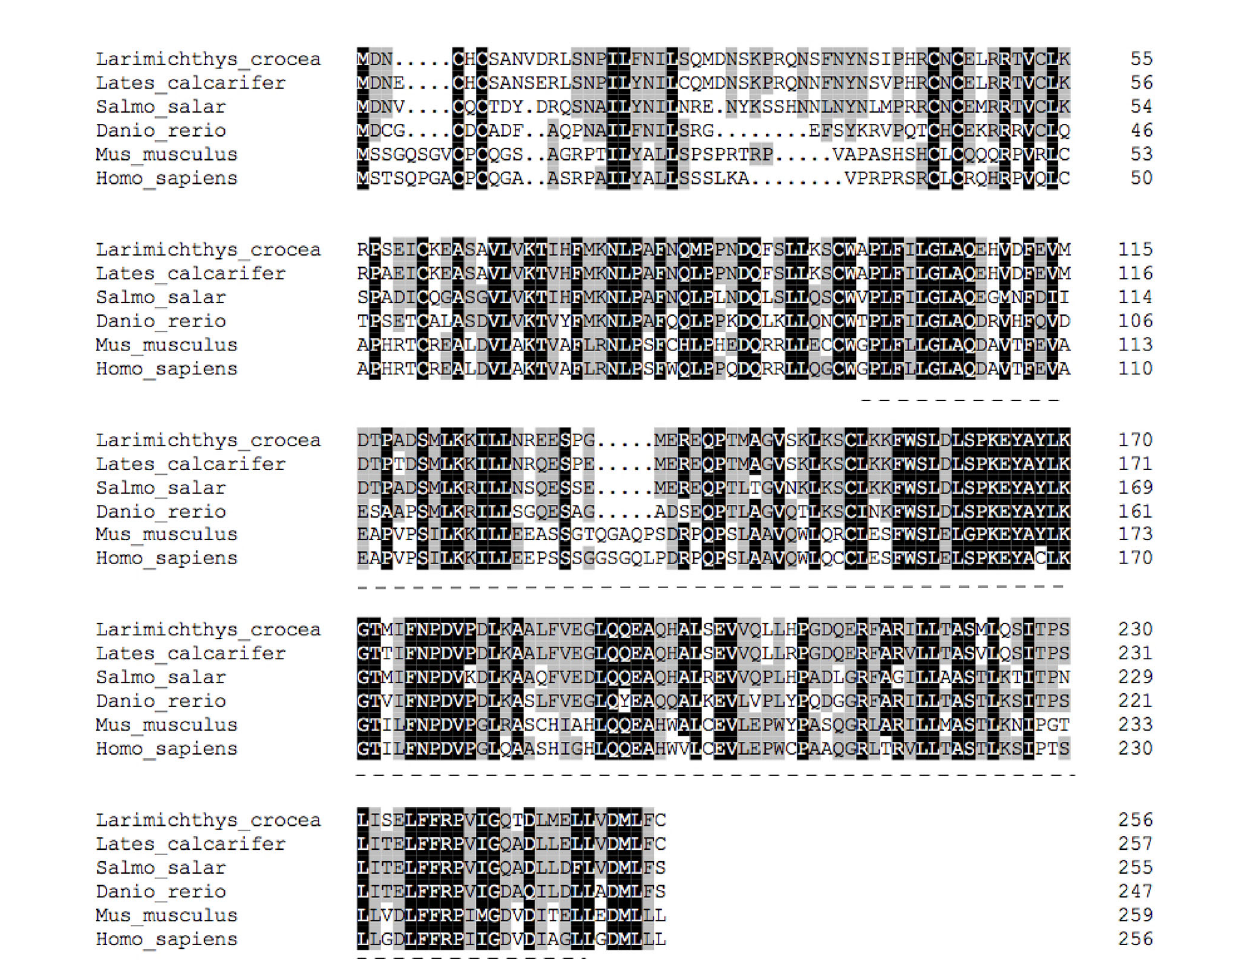
FIGURE 2 | Multiple sequence alignment of SHP with deduced amino acid sequences of other fi sh or mammal animals. Accession numbers used are: Lates calcarifer (XP_018541889.1), Salmo salar (NP_001134122.1), Danio rerio (NP_001243120), Mus musculus (NP_035980.1) and Homo sapiens